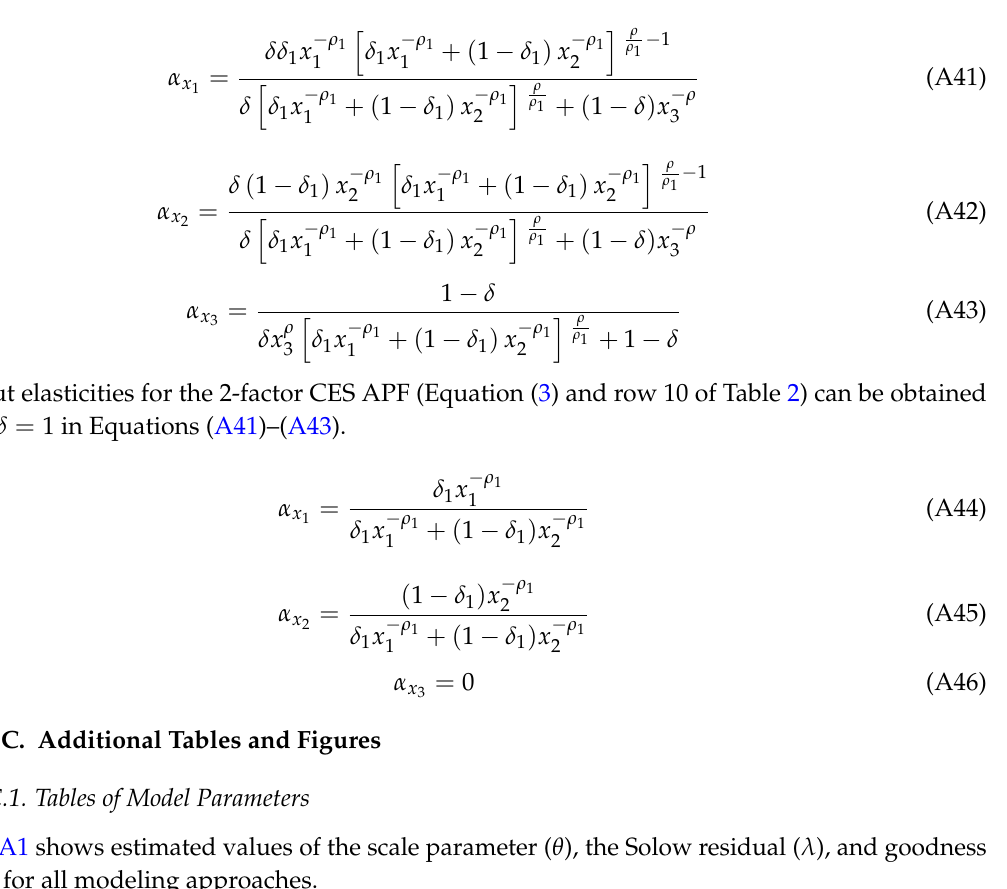
Table A1. Scale parameter ( θ ), Solow residual ( λ ), and sum of squared errors (SSE) for all modeling choices. Country Model CSP Factors of Prod. Energy Nesting Str. θ λ SSE PT Ref. 1.26 0.0357 0.5549 PT CES Adhere Unadjusted Without kl 1.31 0.0169 0.5507 PT CES Reject Unadjusted Without kl 0.99 0.0134 CES Reject Unadjusted With ( kl ) e 1.02 0.0097 0.0373 PT CES Reject Unadjusted With